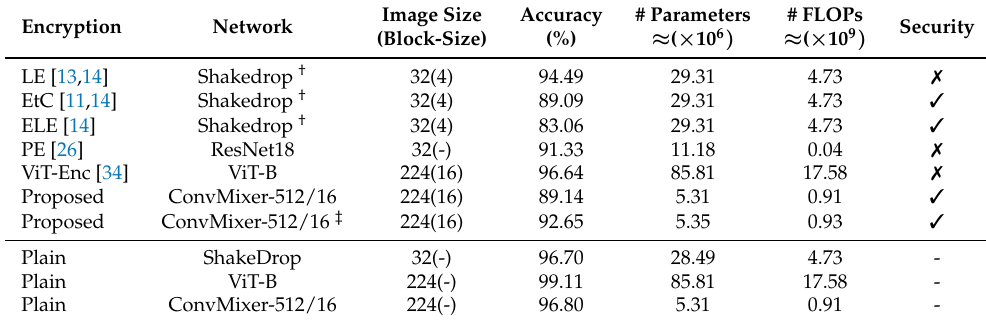
Table 1. Classification accuracy (%) on CIFAR-10 dataset and computation cost of proposed and conventional privacy-preserving image classification methods. ( (cid:51) ) denotes “Strong”, and ( (cid:55) ) de- notes